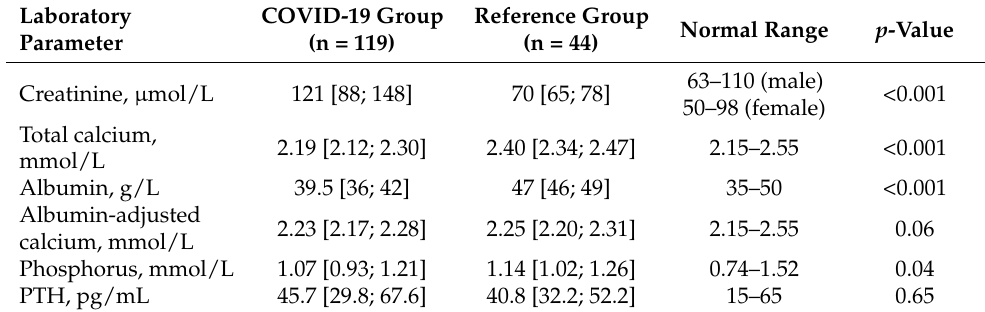
Table 3. Levels of the biochemical parameters and parathyroid hormone (PTH) in COVID-19 patients at the time of admission and in the reference